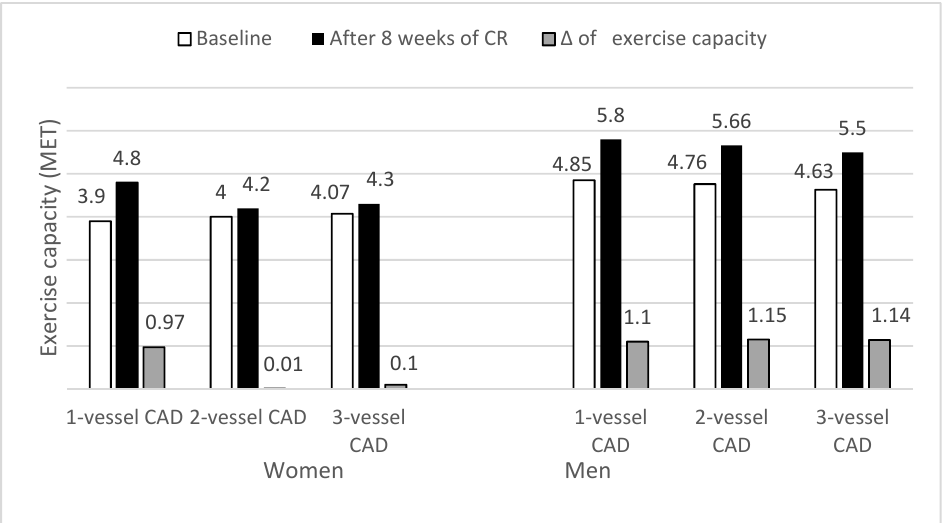
Figure 4. The exercise capacity of examined women and men with CAD at baseline and after 8 weeks of CR program in subgroups created due to the number of coronary vessels affected with athero-sclerosis.